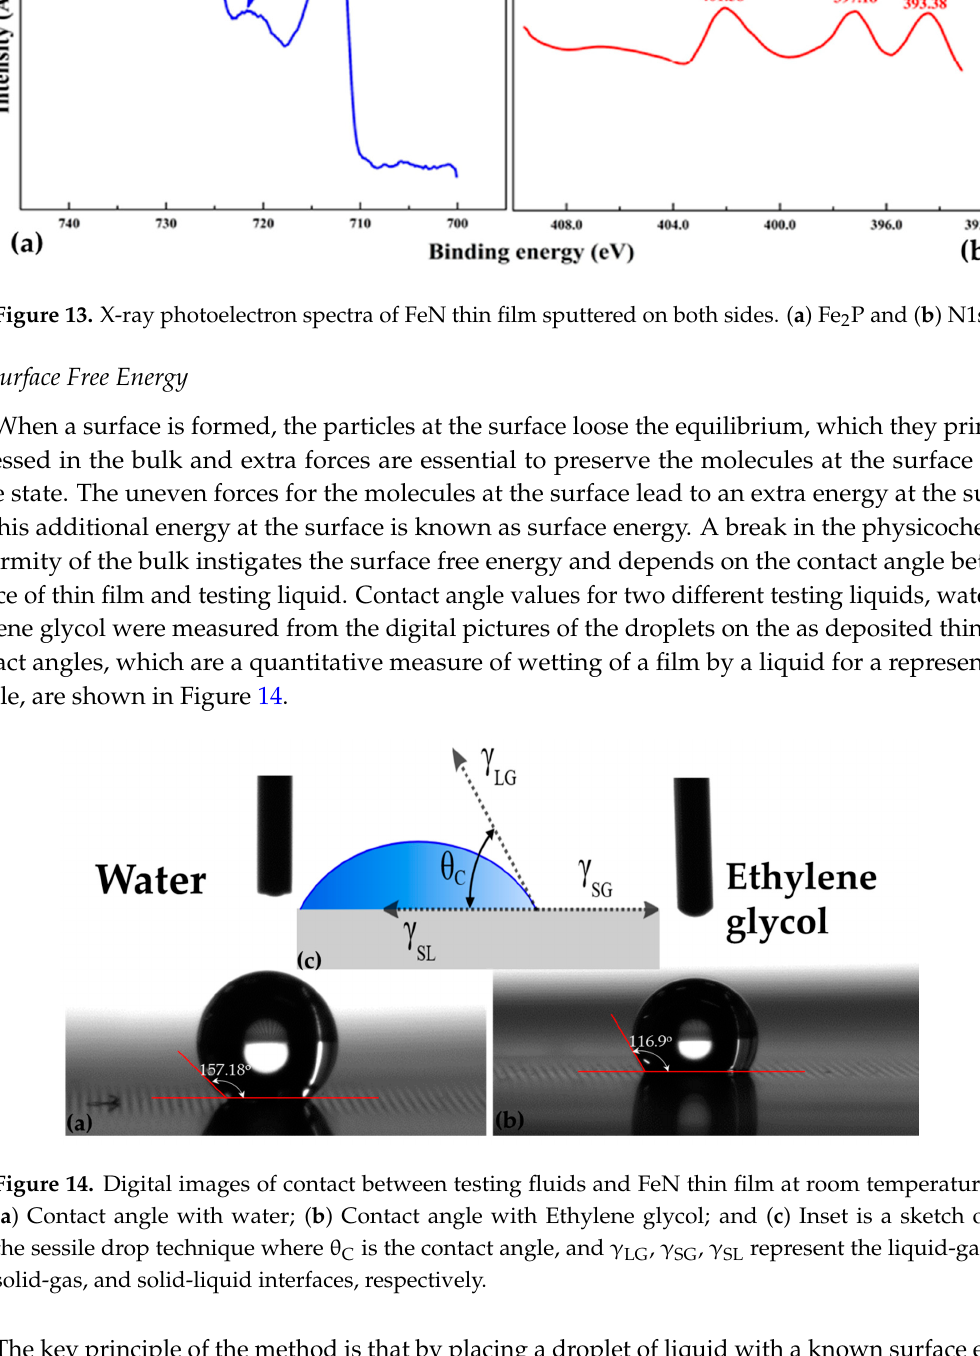
Figure 13. X-ray photoelectron spectra of FeN thin film sputtered on both sides. ( a ) Fe 2 P and ( b ) N1s.